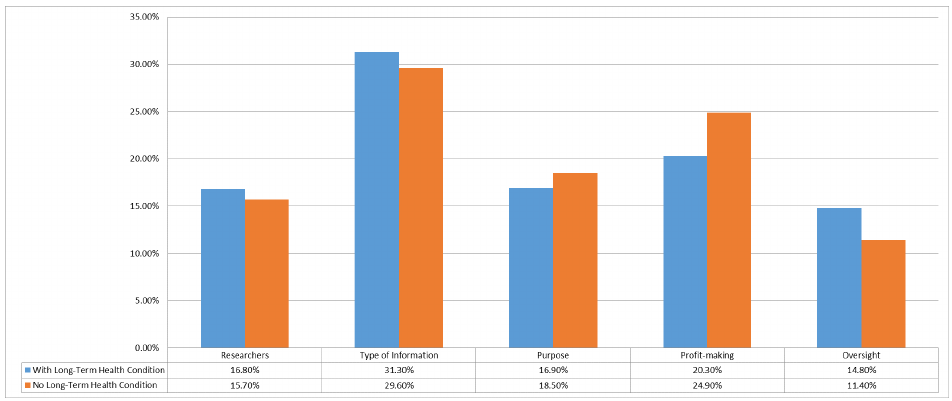
Figure 6: Relative Importance of Attributes for Respondents with and without Long-Term Health